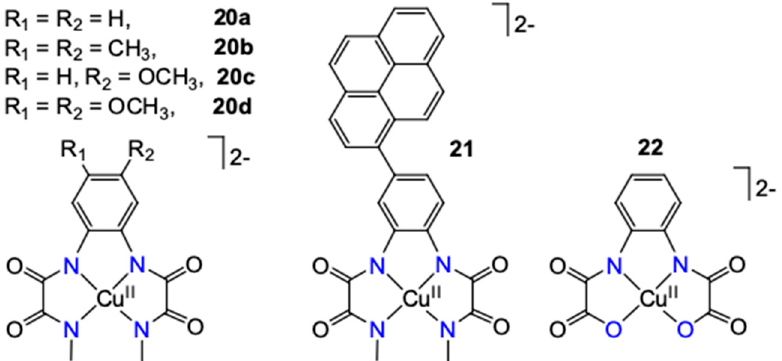
Figure 11. Molecular catalysts with redox non-innocent bis-oxalamide ligands.